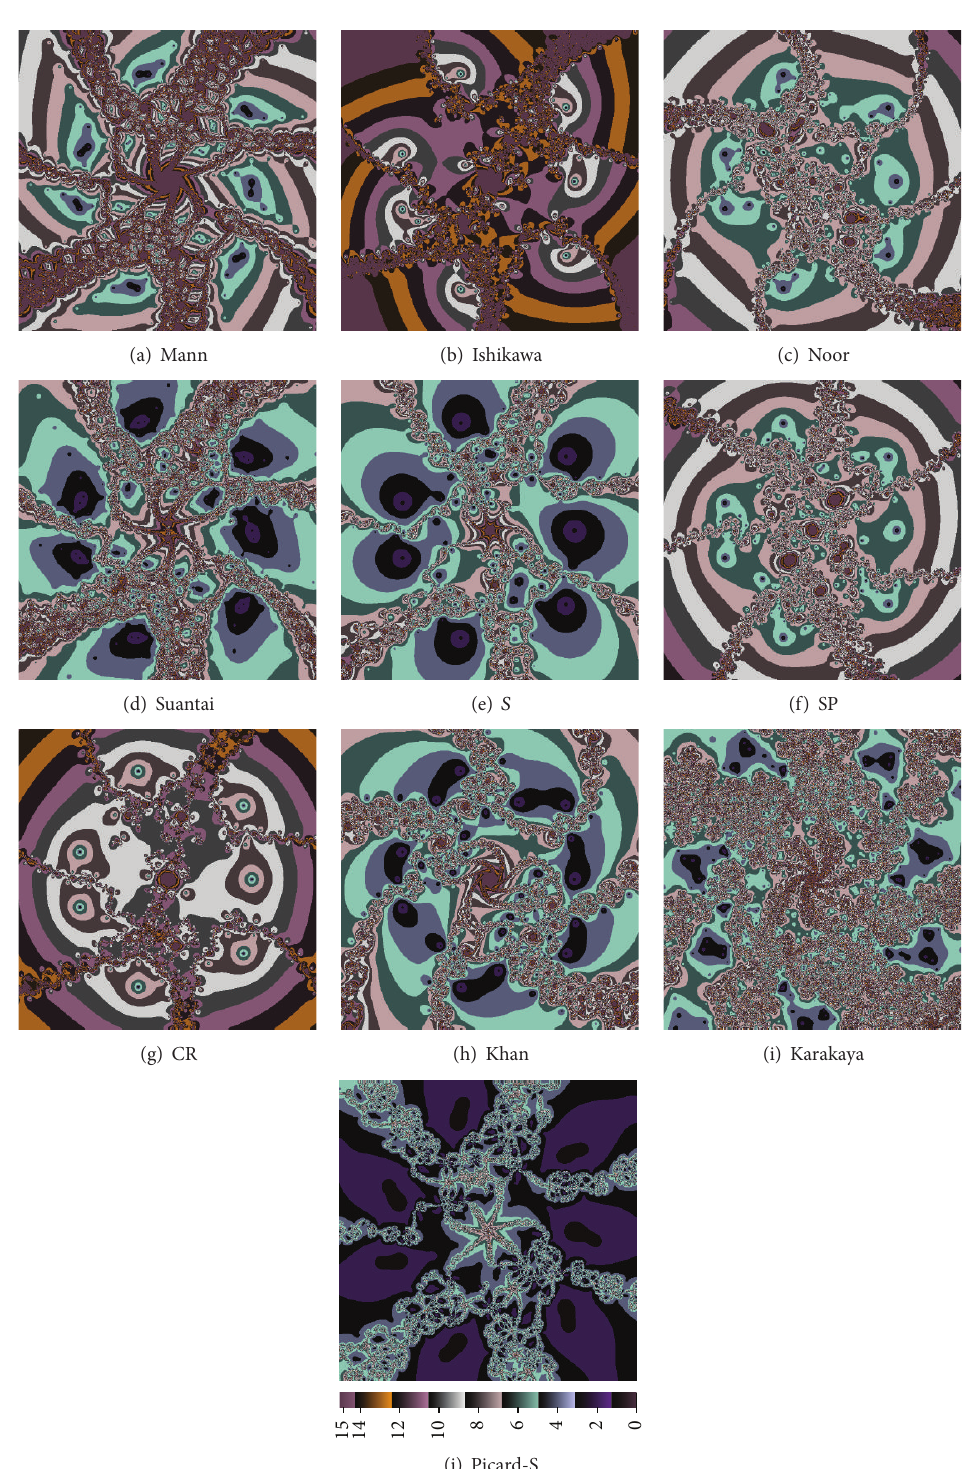
Figure 4: Examples of polynomiographs for 𝑝 1 with complex-valued parameters of